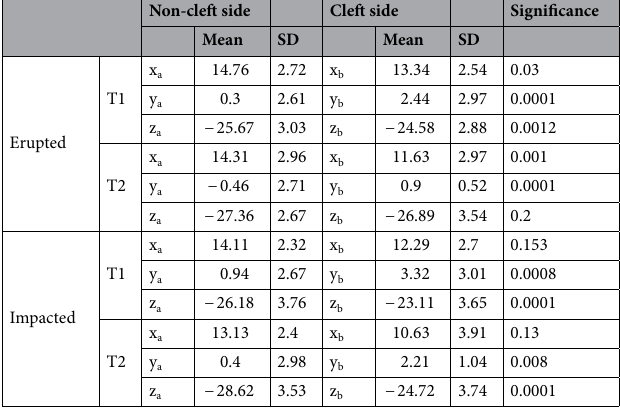
Table 5. (x, y, z) Coordinates of non-cleft side and cleft side canines in T1 and T2.